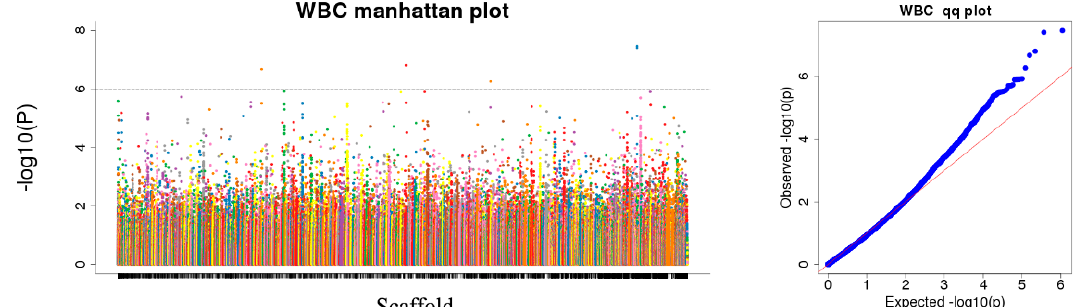
Figure 4. Manhattan plots and quantile–quantile (Q–Q) plots for white blood cell count (WBC). The left side of Figure 4 is the Manhattan map, which is the genetic marker e ff ect value, i.e., the F-tested whole-genome p -value is sorted according to the physical position on the chromosome. The abscissa is the genomic coordinates, and the ordinate is − log10 ( p -value). The smaller the p -value, the stronger the correlation, and the larger the ordinate. The horizontal dashed line in the Manhattan chart indicates the level of significance. When − log10 ( p -value) > 6.26, the SNP is considered to be significantly associated with the trait.